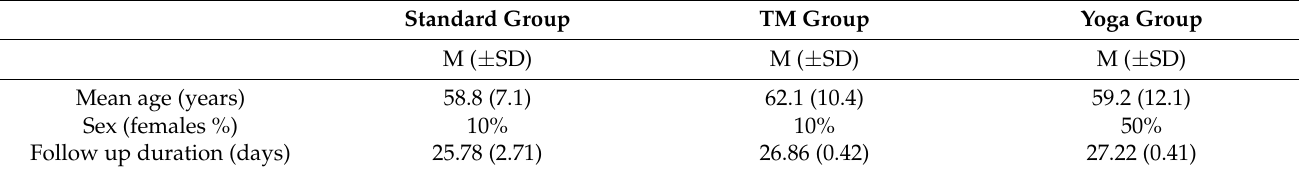
Table 1. Descriptive